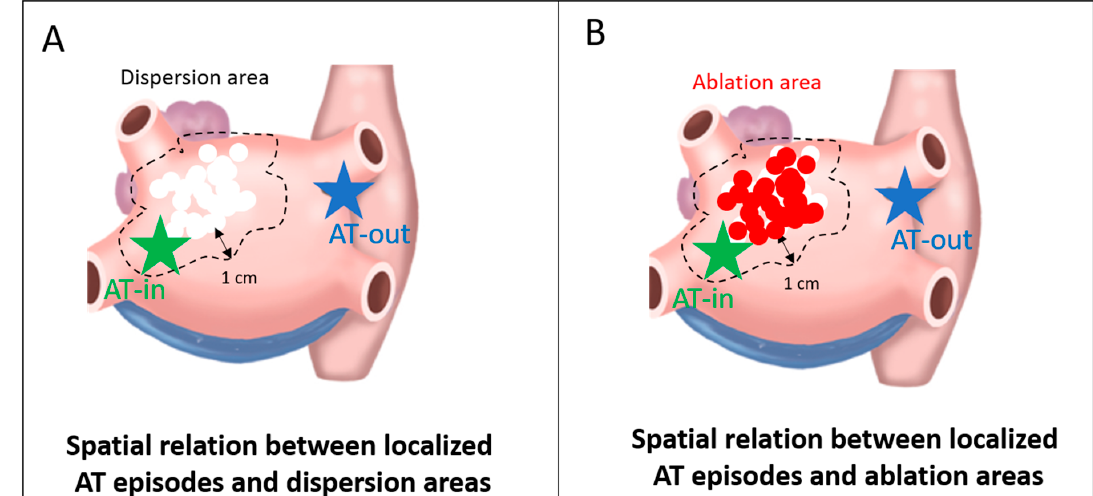
Figure 2. Binary classification of micro-reentrant AT localization. AT-in, localized AT located inside the boundary of the dispersion/ablation area (<1 cm); AT-out, localized AT located outside the boundary of the dispersion/ablation area ( ≥ 1 cm). ( A ) the blue star site is an example of localized AT considered distant (AT-out) from dispersion area, while the green star site is considered to be related (AT-in) to the dispersion region. ( B ) the blue star site is an example of localized AT considered distant (AT-out) from previously ablated area, while the green star localized AT site is considered to be related (AT-in) to the ablation region.